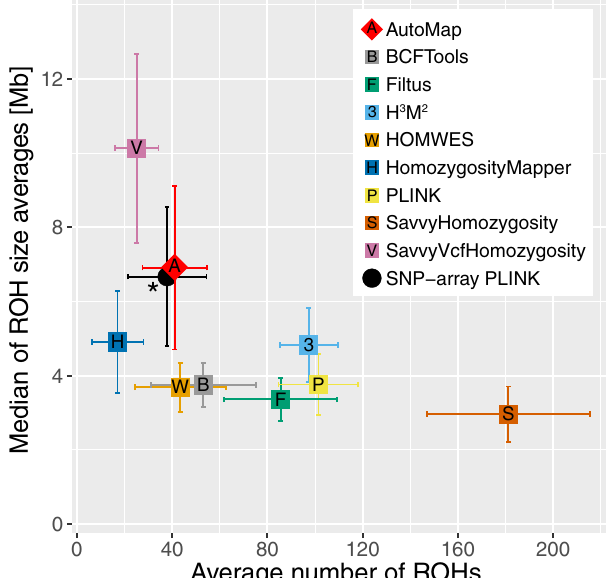
Fig. 3 Average number of ROH detected per sample ( N = 26) vs. the median of the size averages of ROHs per sample (ROHs larger than 1 Mb). The asterisk indicates the reference value used for comparison, i.e., data from SNP arrays analyzed with PLINK. Error bars represent standard deviations of the mean. Source data are provided in the Source Data